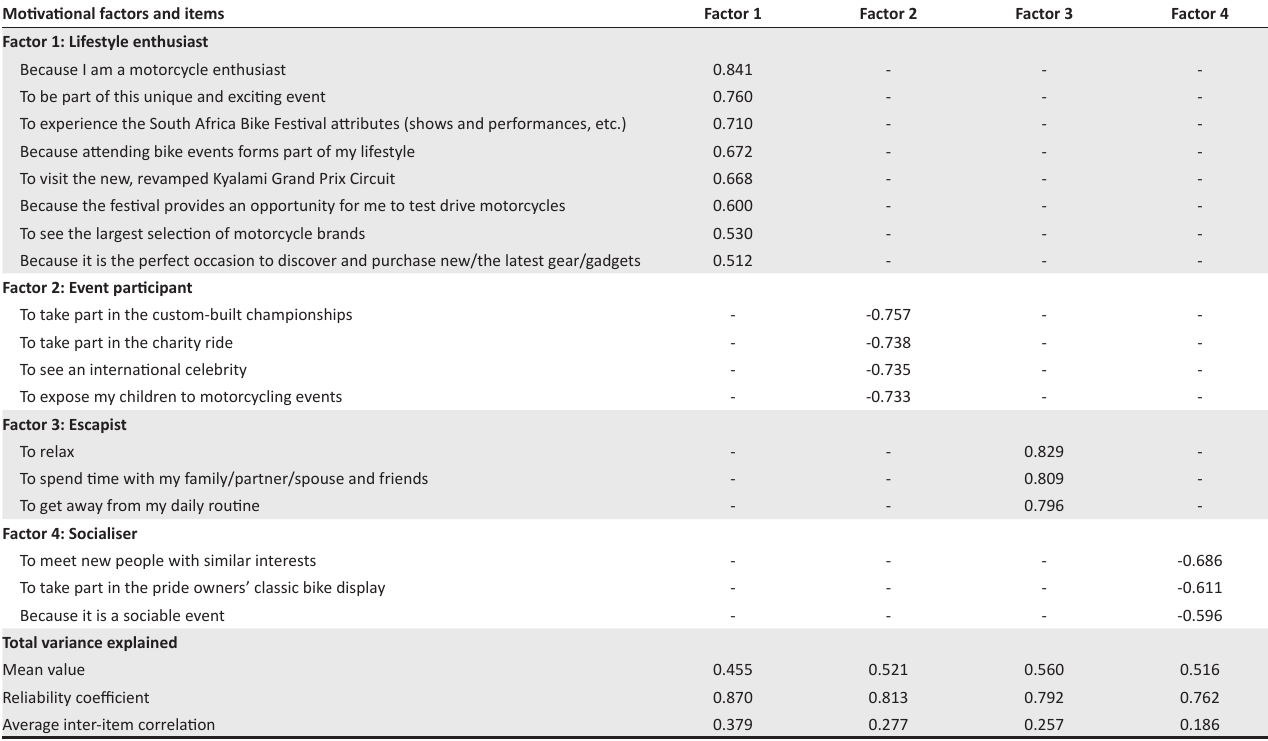
TABLE 1: Motivational factors. Motivational factors and